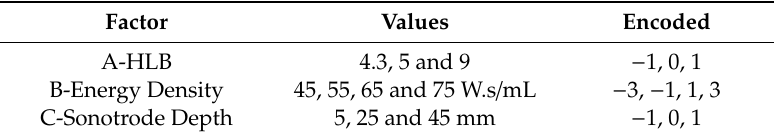
Table 6. Factors encoded.